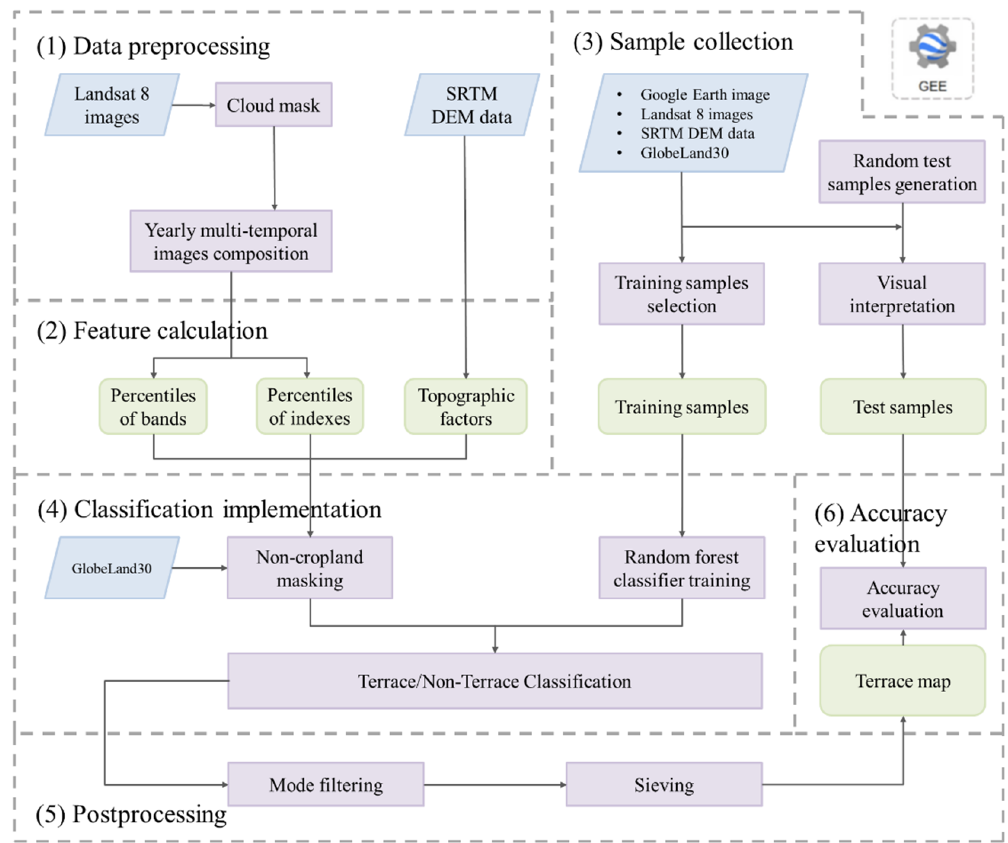
Figure 1. The framework of terrace/non-terrace classification applied in the current study. The whole project was accomplished based on the GEE